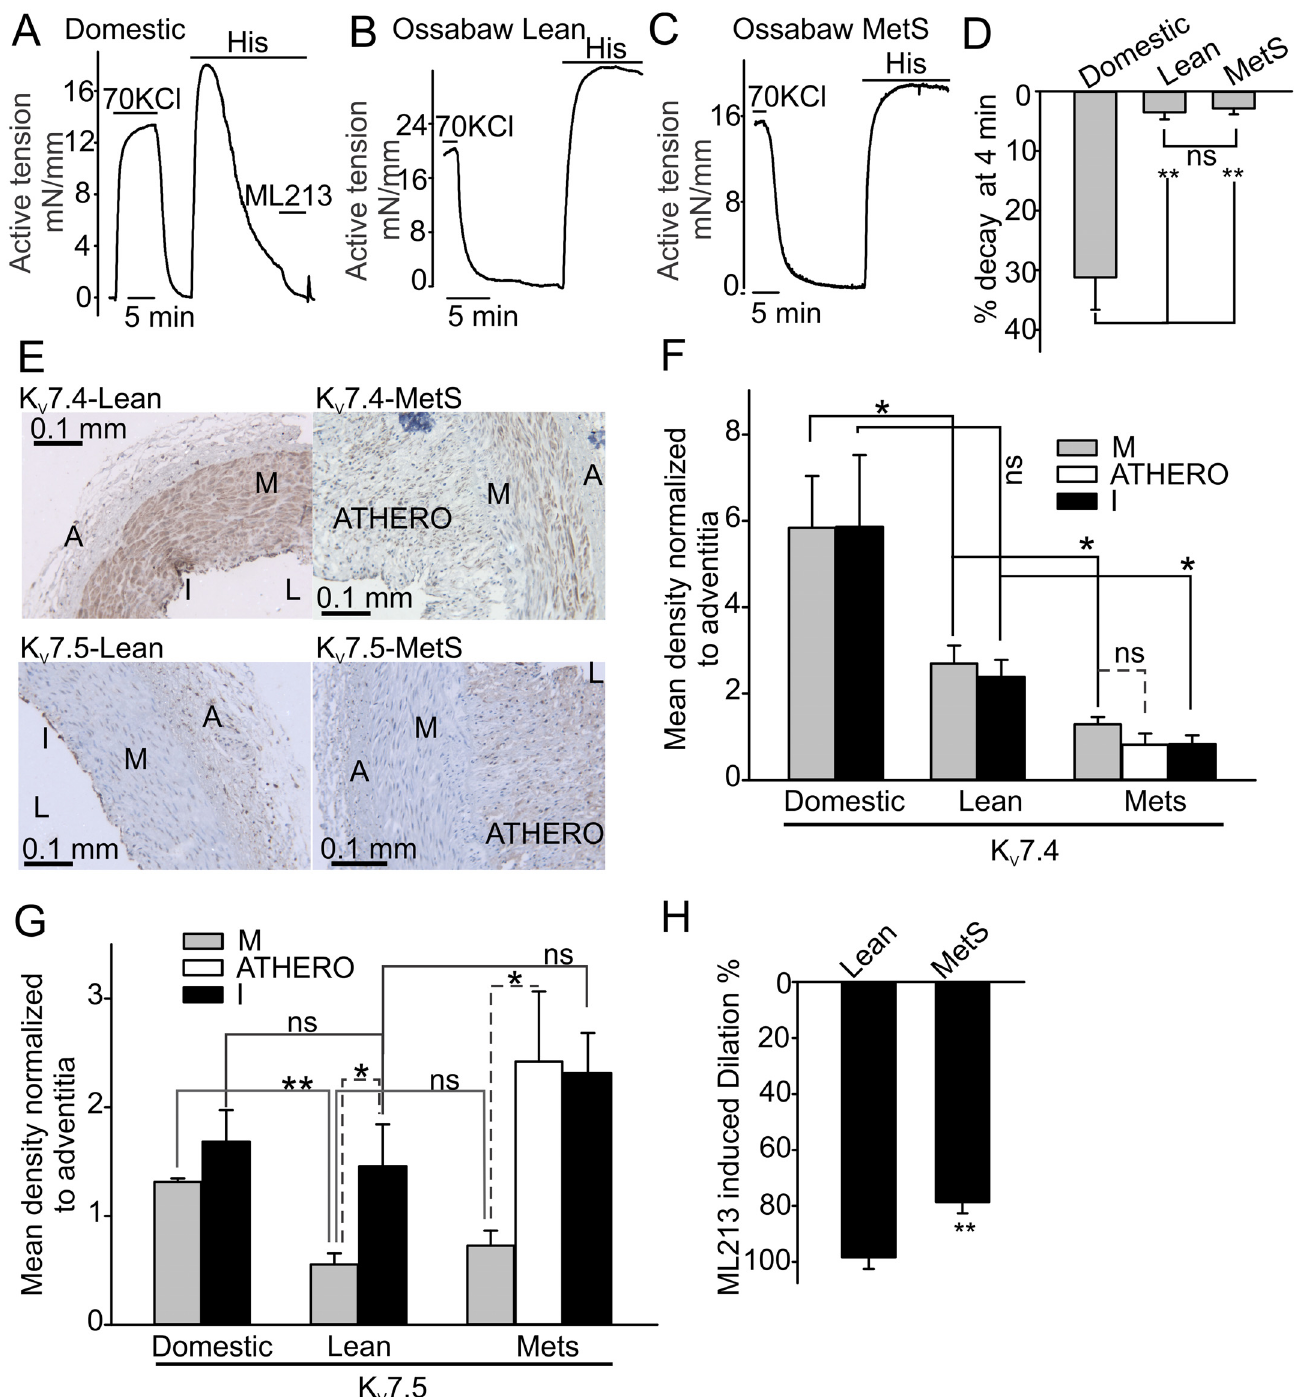
Fig 5. K v 7.4 and K v 7.5 immunostaining and function in Ossabaw pig CAs. A-D , Sample isometric tension recordings and summary data illustrating different decay rates of histamine-induced contractions observed in domestic and Ossabaw CA rings (Domestic: n = 7; Lean: n = 7; MetS: n = 5). E shows the pattern of K v 7.4 and K v 7.5 protein distribution across the conduit coronary artery cross-sectional segments from Ossabaw pigs. F and G , Summary data for K v 7.4 and K v 7.5 protein distribution. The ratio of the background-corrected intensities of media-intimal layer and the adventitia layer staining was calculated to quantify the relative expression levels of the K v 7 proteins (Domestic: n = 3; Lean: n = 4; MetS: n = 3). H shows the summary data illustrating 10 μ M ML213 dilatory effects in histamine pre-contracted rings from Ossabaw lean and MetS pigs (Lean: n = 5; MetS: n = 6).